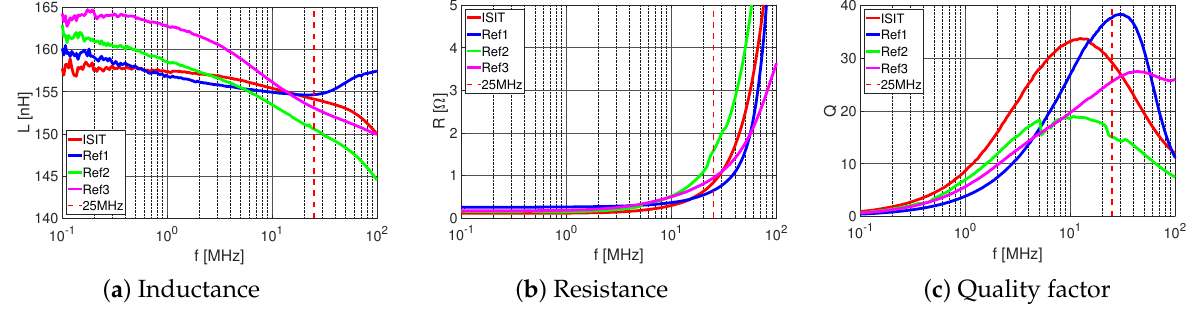
Figure 13. Measurement results from impedance analyzer.